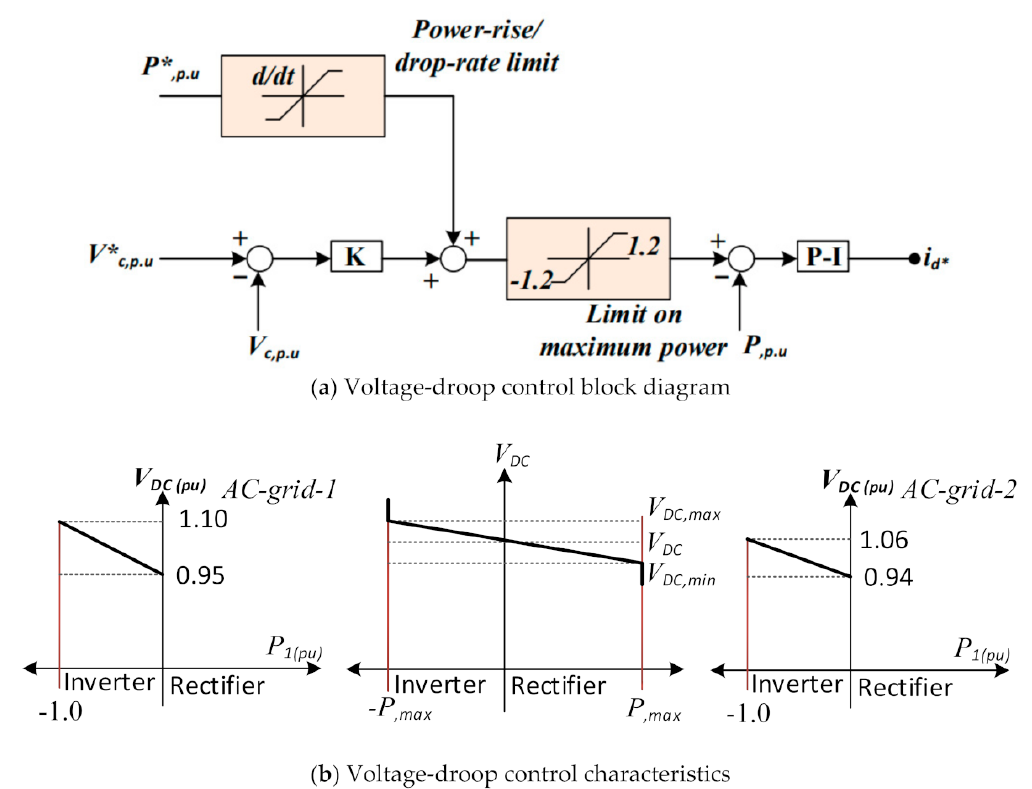
Figure 4. ( a ) Voltage-droop control block diagram, ( b ) Voltage-droop control